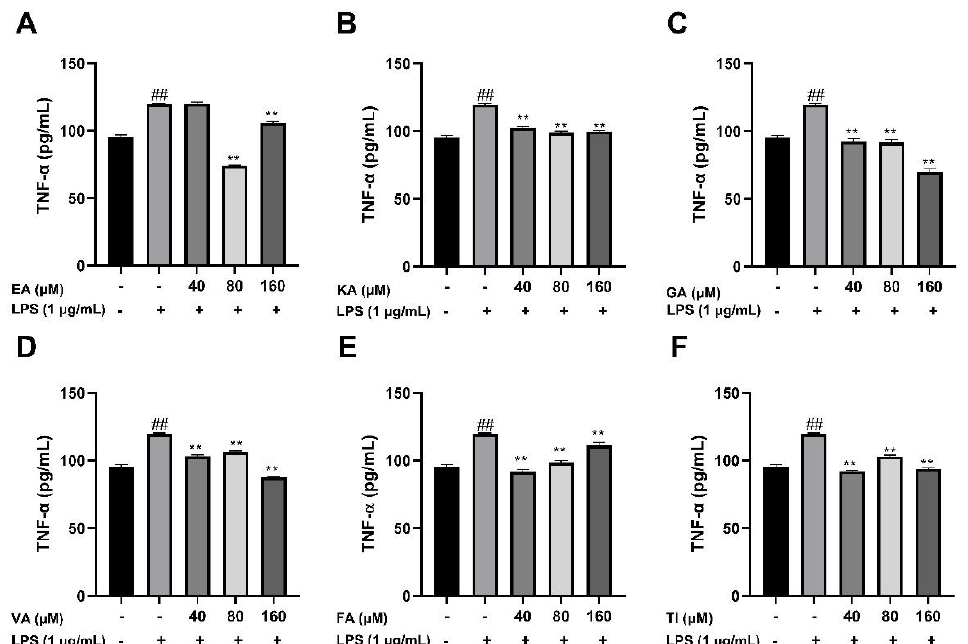
Figure 18. Effects of Ellagic acid ( A : EA), Kaempferol-3-o-rutin glycoside ( B : KA), Gallic acid ( C : GA), Vanillic acid ( D : VA), Ferulic acid ( E : FA), and Tiliroside ( F : TI) on LPS -induced TNF- α in BV2 cells at high (160 µ M), medium (80 µ M) and low (40 µ M) concentrations. − indicates that contain, + indicates does not contain. ## represent significant difference between the representative model group and the control group. * represents significant difference compared with model group (P < 0.05); and ** represents extremely significant difference compared with model group (P < 0.01).